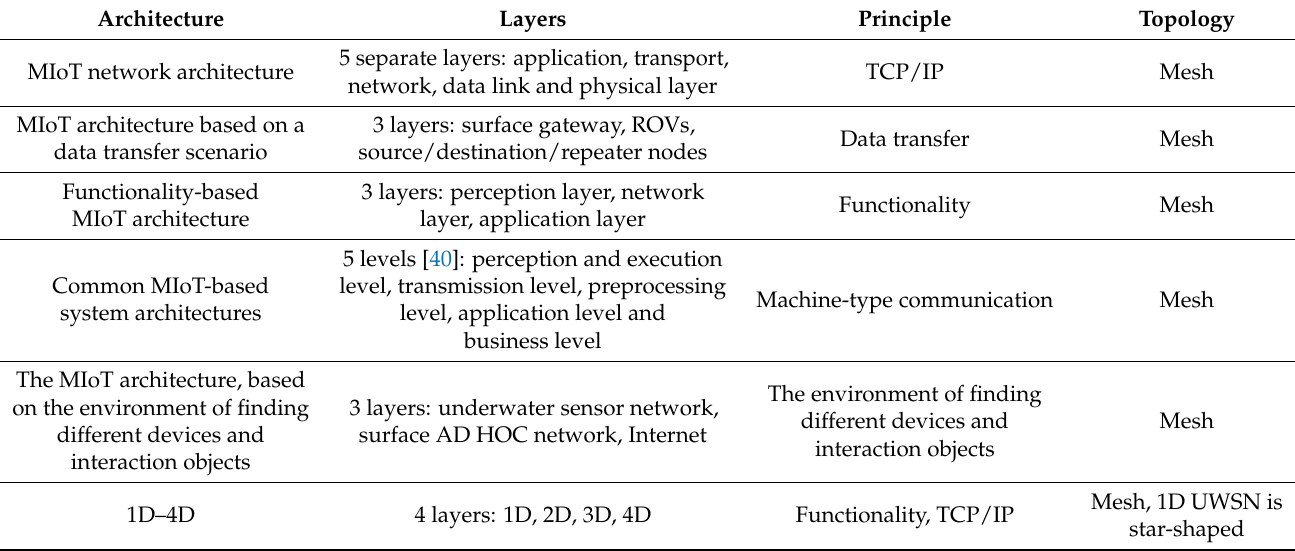
Table 5. Comparison table of three MIoT system